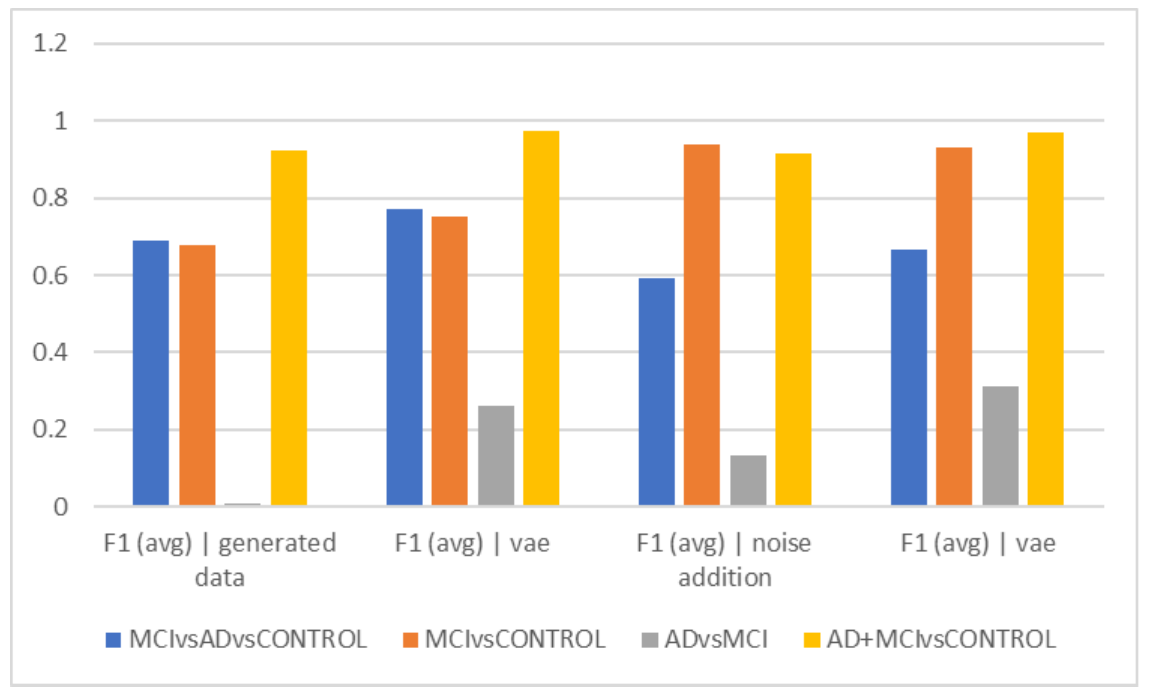
Figure 7. Comparison of results for a period of 15 s (F1).